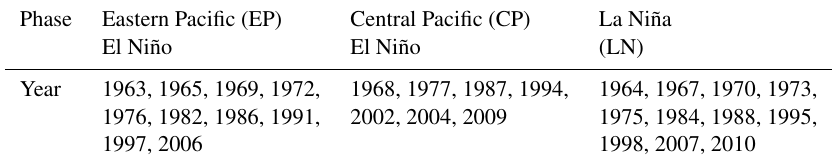
Table 2. ENSO emerging years from 1960 to